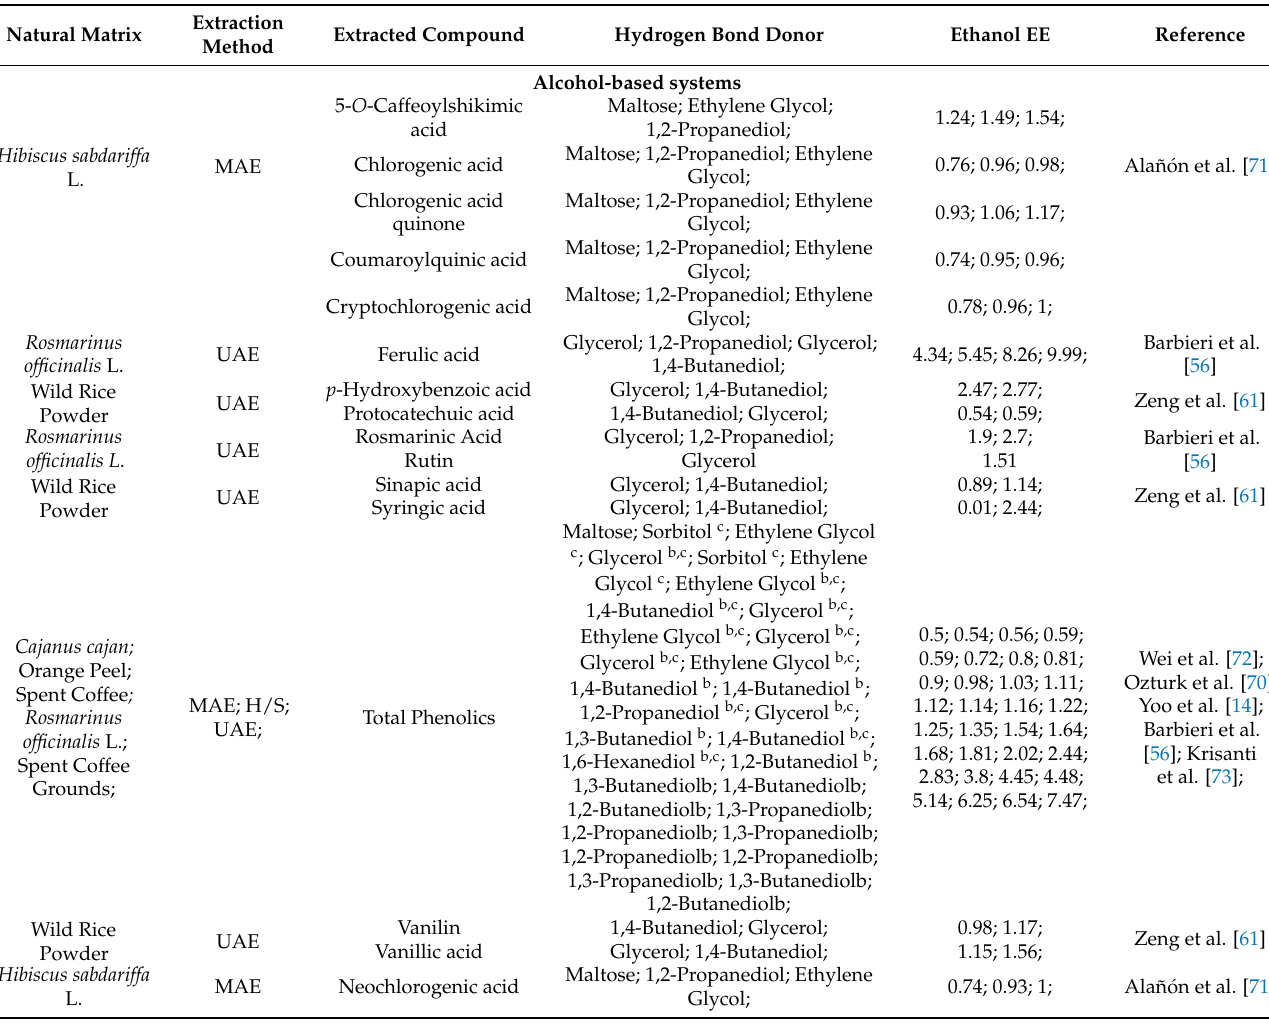
Table 5. Correlation between the natural matrix, extraction method, and DES based on ammonium salts (choline chloride and betaine) and the effect of different HBDs on the extraction efficiency of different phenolic acids compared with ethanol